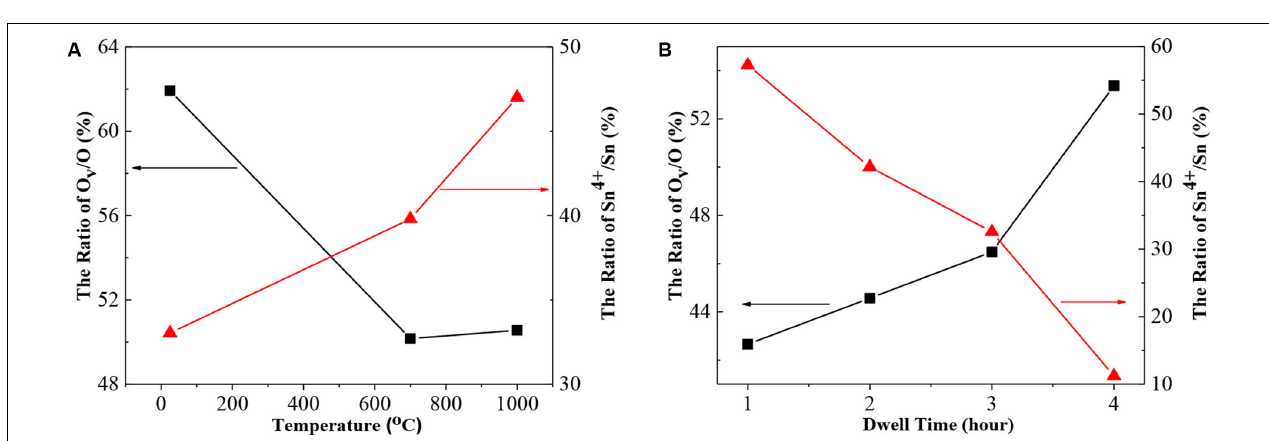
FIGURE 8 | The ratio of Ov/O and Sn 4 + of the ITO films presented as a function of (A) temperature and (B) dwell time, heated at 1,000 ◦ C.